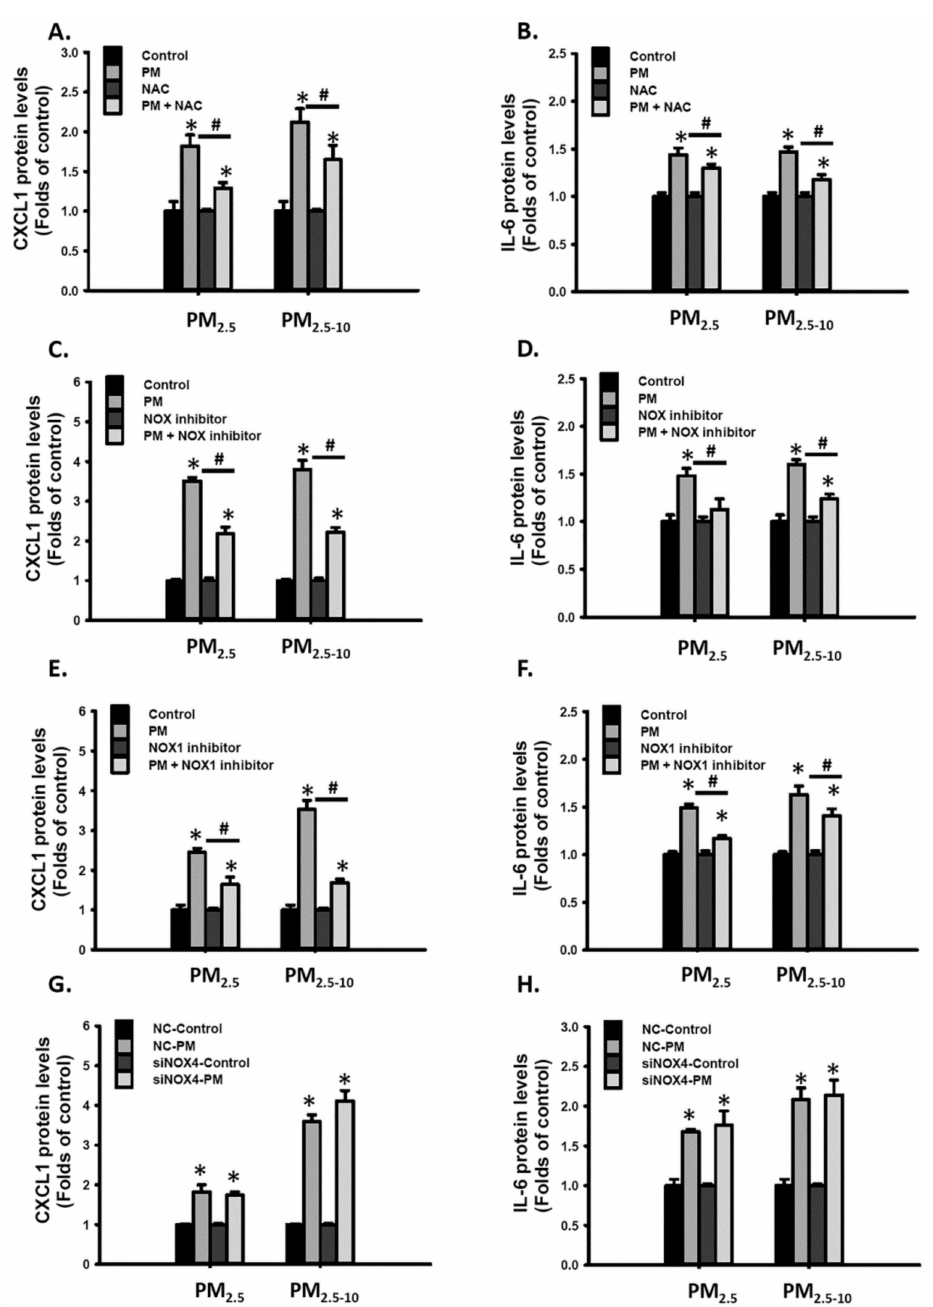
Figure 5. PM 2.5 and PM 2.5-10 increased inflammatory cytokine secretion partially through the NOX1-ROS signaling pathway in MVSMCs. MVSMCs were treated with d 2 H 2 O or 25 µ g/mL PM 2.5 or PM 2.5-10 with and without 10 µ M NAC for 48 h. ( A ) CXCL1 and ( B ) IL-6 protein concentrations were measured in the media. MVSMCs were treated with d 2 H 2 O or 25 µ